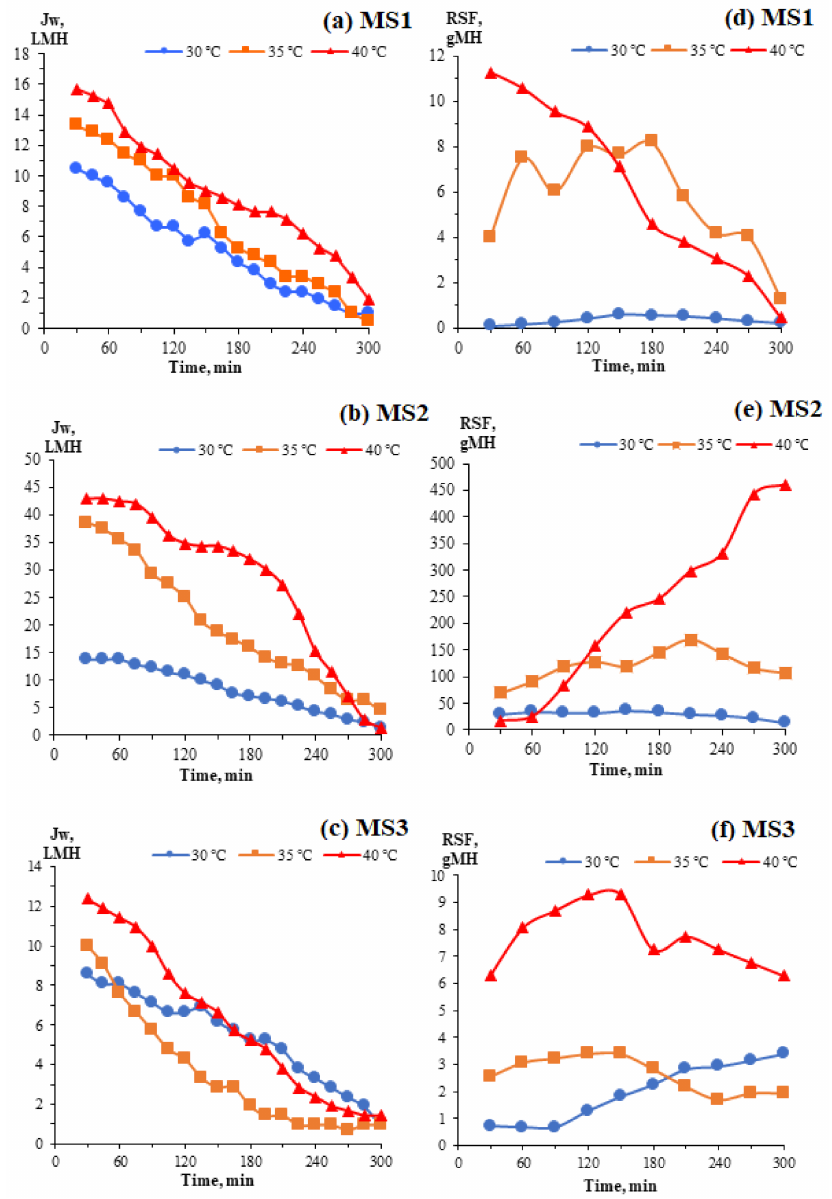
Figure 7. FO water fluxes ( a – c ) and RSFs ( d – f ) of the TFC FO membranes at different